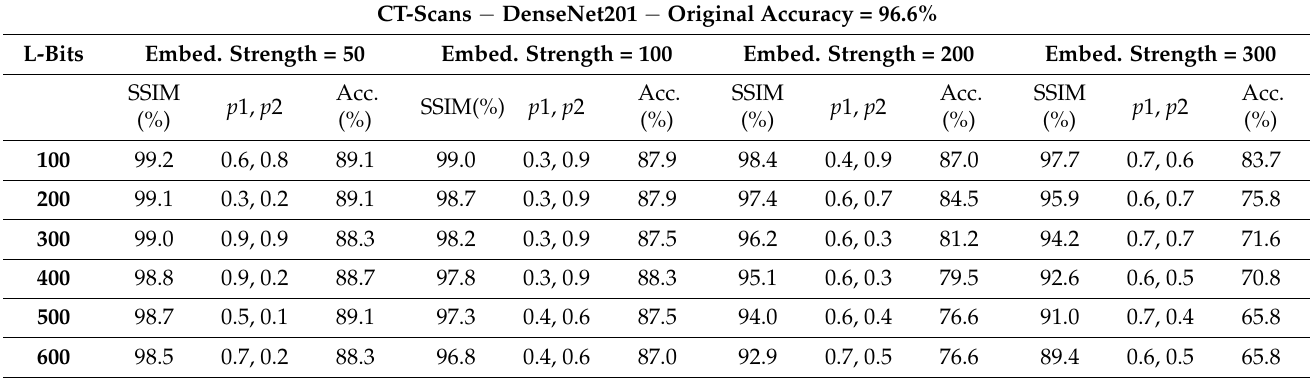
Table A5. KMsWA 2 attacks on DenseNet201 in